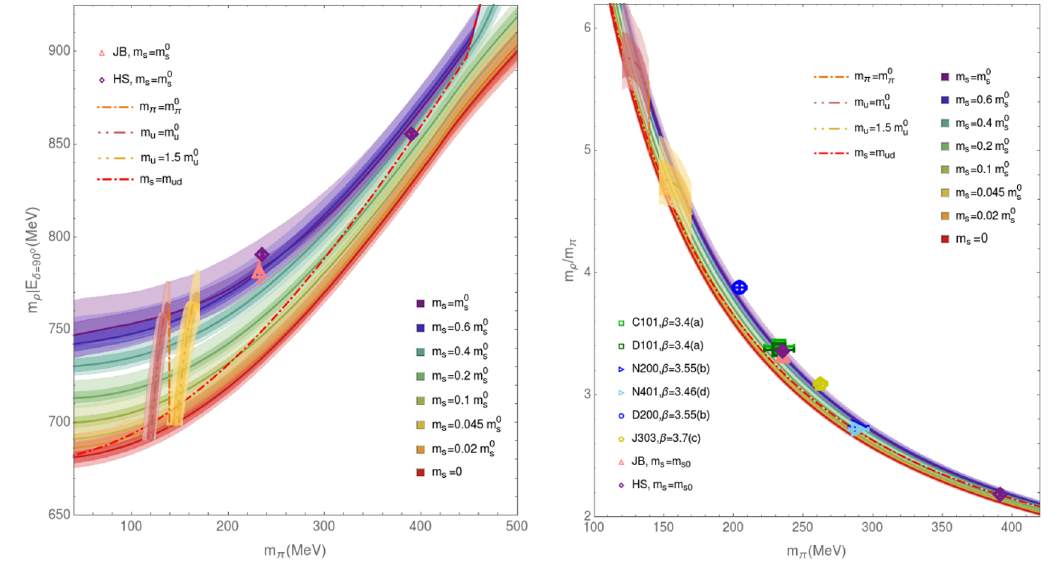
Figure 24 . The (cid:26) -meson mass (left) and normalized (cid:26) mass (respect to the pion mass) (right) as a function of the pion mass for the m s = k , m u = c , m (cid:25) = m 0 m = c trajectories where the mass of the u quark (or pion) is kept (cid:12)xed and only m u;(cid:25)